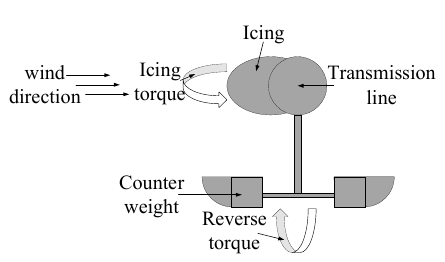
Figure 8. Icing torsion process of conductor.